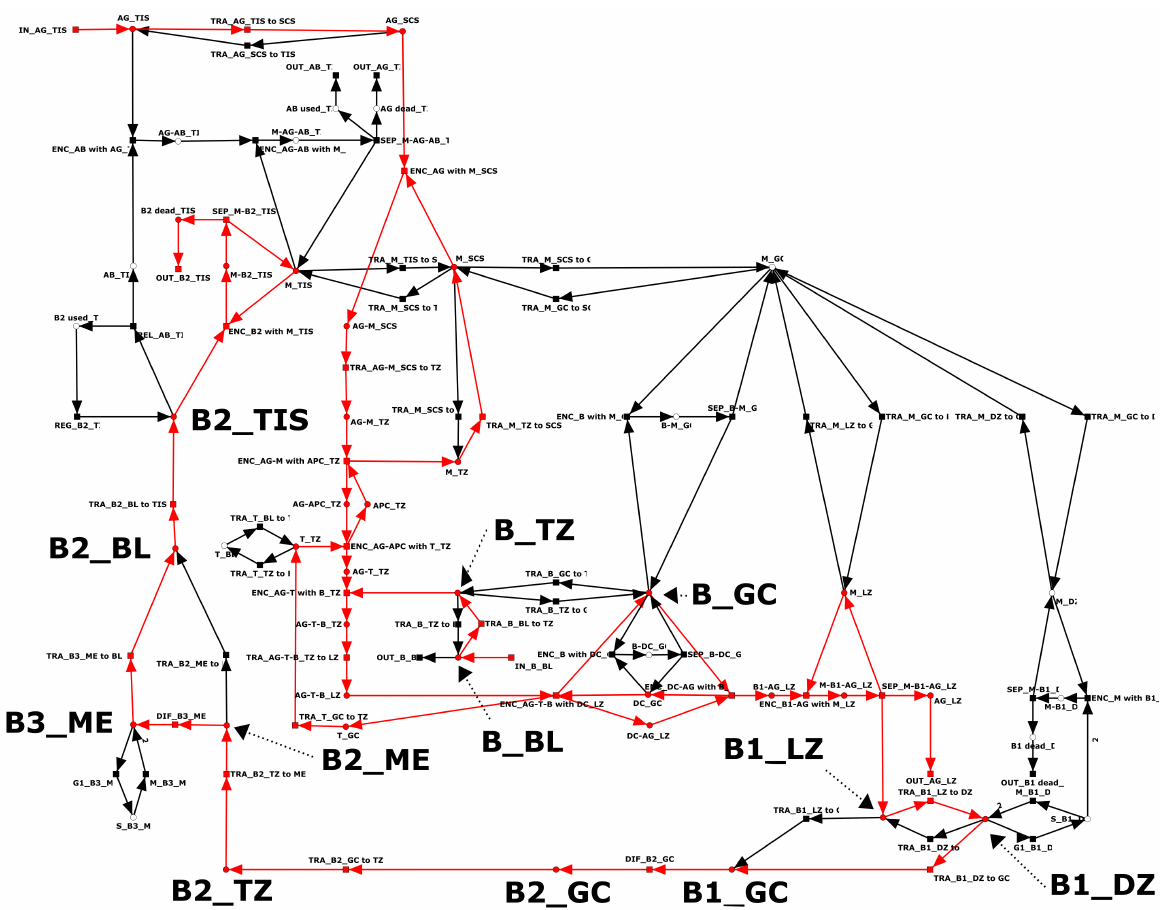
Figure 3. Exemplary transition invariant TI-8. The 28 transitions of TI-8 are highlighted in red. TI-8 characterizes a possible pathway of B cell activation induced by the invasion of antigens. B cells may move from the blood (place: B_BL ) to the T zone (place: B_TZ ) and then, after activation, pass via the light zone, dark zone, germinal center, T zone, medulla, and blood to the tissue (places: B1_LZ , B1_DZ , B1_GC , B2_GC , B2_TZ , B2_ME , B3_ME , B2_BL , B2_TIS ). B cells differentiate in several steps to become activated, and eventually become degraded in the tissue. For the abbreviations used to name the places, refer to Tables 1 and 2. For a list of TIs, refer to Table